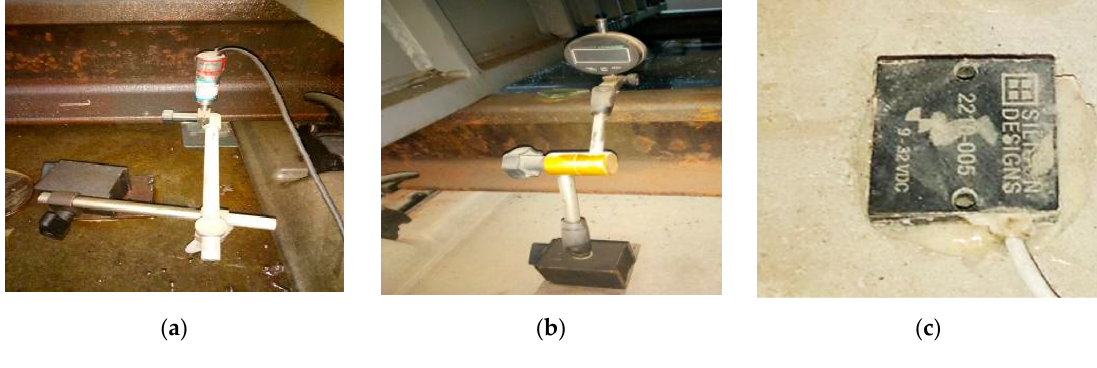
Figure 3. Figures of typical test components installed for use. ( a ) Dynamic displacement meter; ( b ) dial indicator; ( c ) accelerometer.